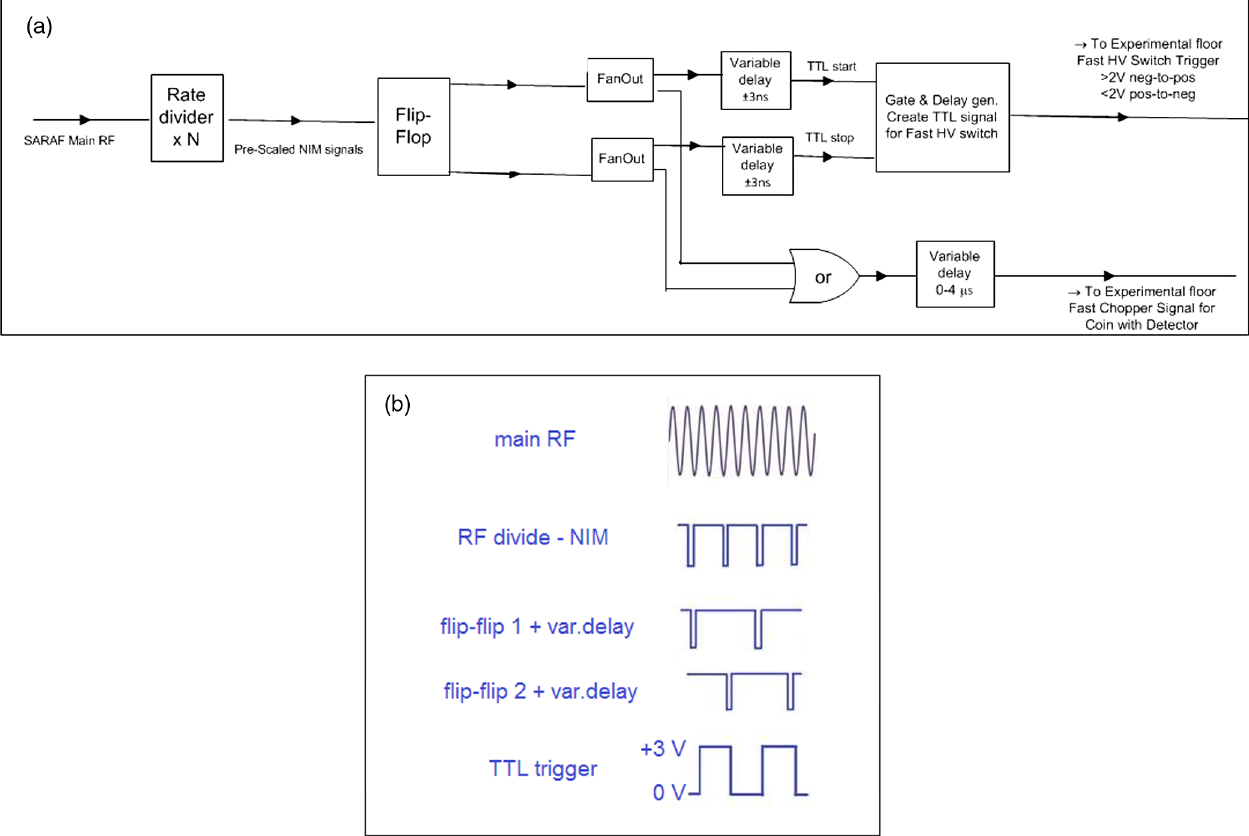
FIG. 7. (a) Electronic logic diagram of trigger for the fast chopper HV switch. (b) The trigger involves a down scale of the main SARAF rf to the desired single bunch repetition rate, separate variable delays for the negative-to-positive and positive-to-negative HV swings, and formation of appropriate TTL pulse required for the Behkle HV